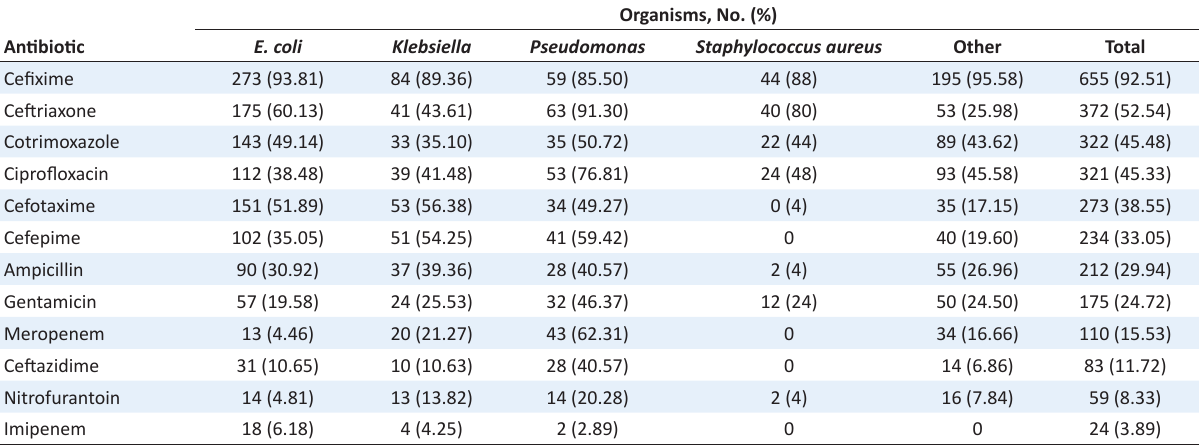
Table 1. Antimicrobial resistance pattern of bacterial pathogens isolated from positive culture